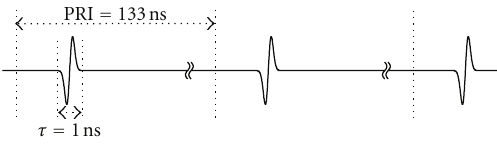
Figure 1: Train of transmitted